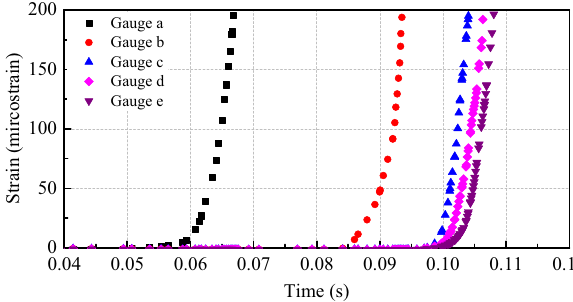
Figure 4: Strain – time curves at outlet water pressure of 0.2 MPa.